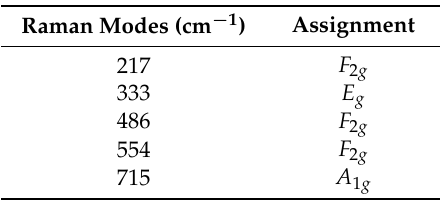
Table 1. Raman modes of MgFe 2 O 4 [36].